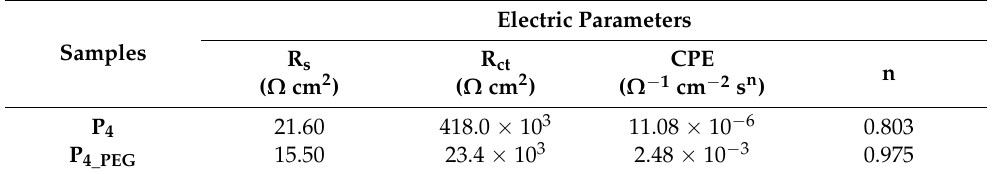
Table 5. Electric parameters from fitting experimental EIS data.